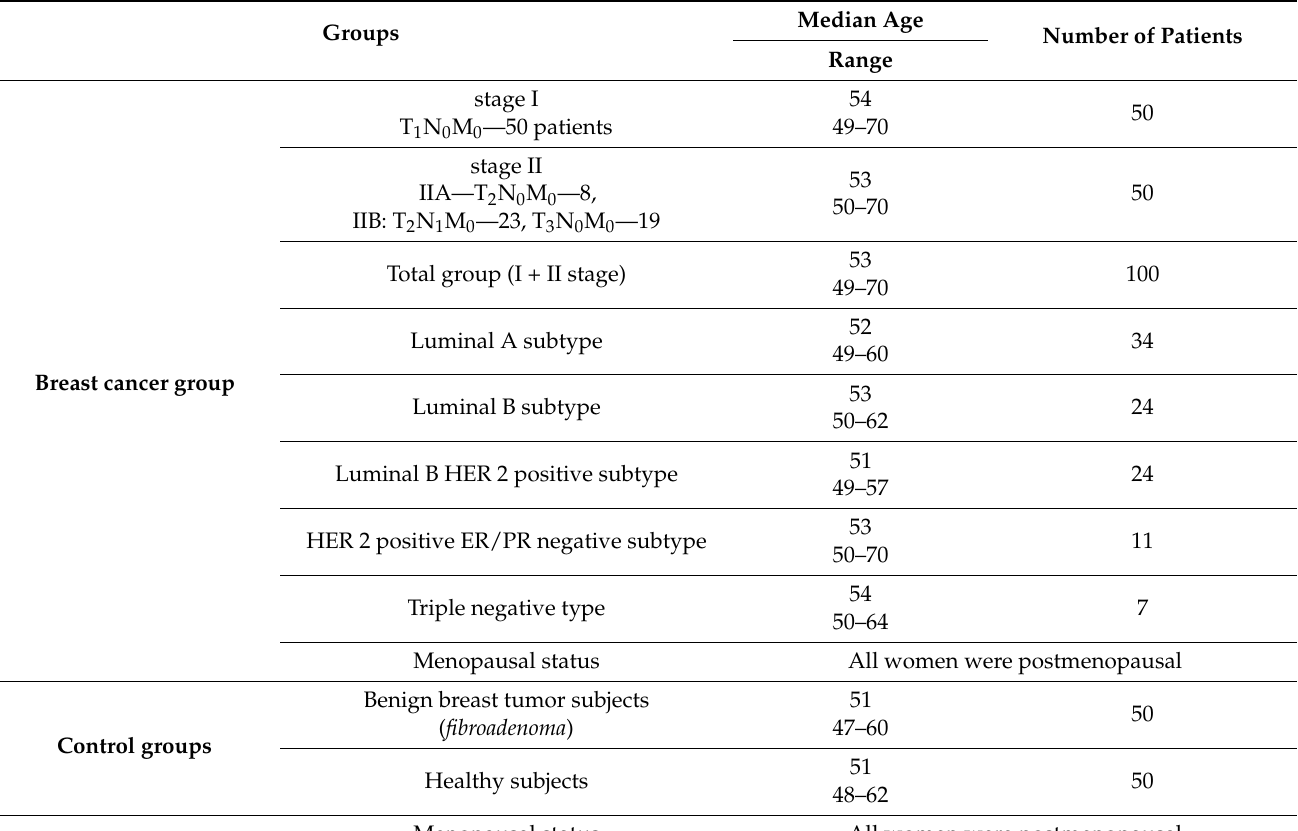
Table 1. Characteristics of study and control